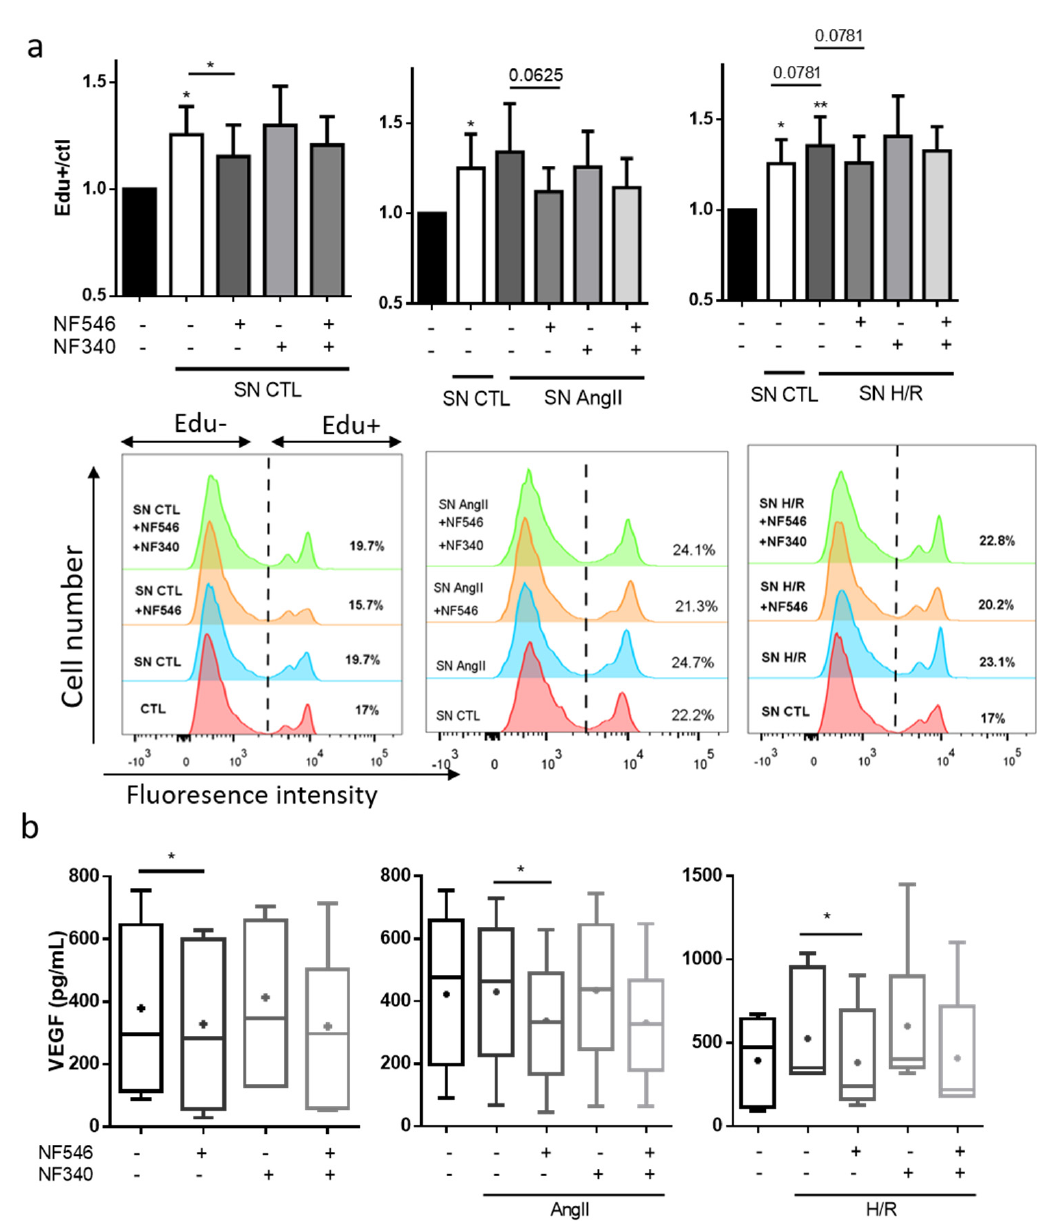
Figure 6. P2Y11R modulates growth factors secretion in the crosstalk between SMC and EC. ( a ) HUVECs were incubated with basal medium, AngII (100 nM) or submitted to 5 h hypoxia followed by 12 h reoxygenation (H/R), and addition of P2Y11R agonist NF546 (10 µ M) and antagonist NF340 (10 µ M). Supernatant (SN) was harvested after 12 h and incubated with HCASMC and EdU (10 µ M) for 24 h. HCASMC proliferation was evaluated by Edu incorporation (n = 7). CTL HUVECs supernatant significantly increased HCASMC proliferation compared to the basal medium. NF546 significantly decreased this pro-proliferative effect. HUVEC AngII-conditioned medium increased HCASMC proliferation compared to the HUVEC basal conditioned medium. NF546 tended to decrease this pro-proliferative effect ( p = 0.06). HUVEC H/R conditioned medium tended to increase HCASMC proliferation compared to HUVEC basal conditioned medium ( p = 0.07). NF546 tended to decrease this pro-proliferative effect ( p = 0.07). ( b ) HCASMC were incubated with basal medium, AngII (100 nM) or submitted to 5 h hypoxia followed by 24 h reoxygenation (H/R), and addition of P2Y11R agonist NF546 (10 µ M) and antagonist NF340 (10 µ M). VEGF secretion was evaluated in the supernatant by ELISA assay. AngII did not modify VEGF secretion and H/R tended to increase VEGF secretion. VEGF secretion was decreased by NF546 in the CTL (n = 7), AngII (n = 9) and H/R (n = 7) groups. * p < 0.05 and ** p < 0.01, compared to the CTL condition, if not indicated. Data given as mean ± SEM and box plot as median and mean + min to